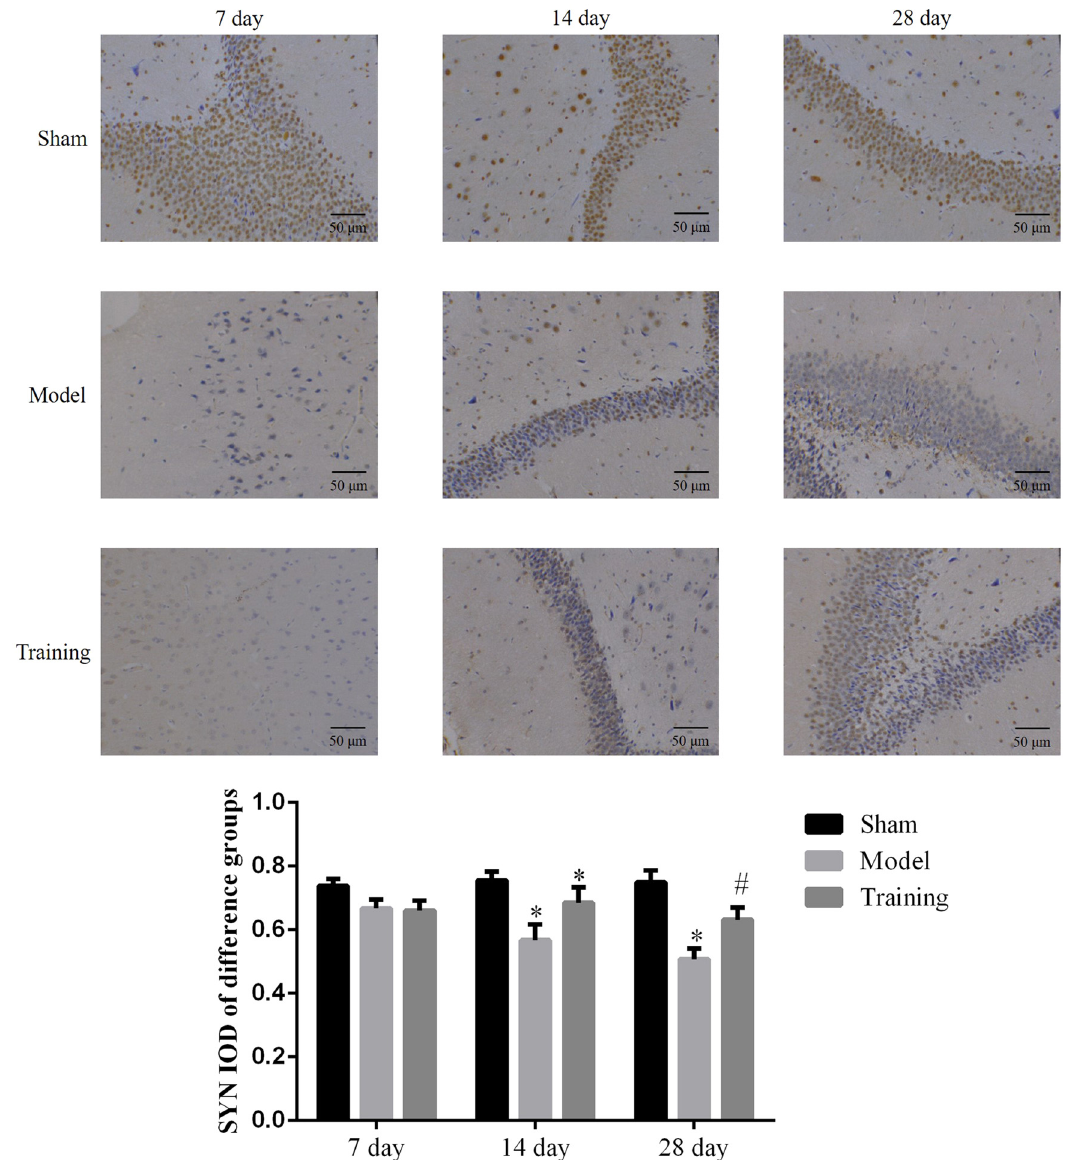
Figure 4: The SYN protein expression of di ff erent groups by IHC assay (× 200 ) . Sham: Sham group; Model: nerve injuries in CCI rat model; Training: nerve injuries in CCI model rats that were treated with rehabilitation training exercises; * P < 0.05 compared with the Sham group; # P < 0.05 compared with the Model